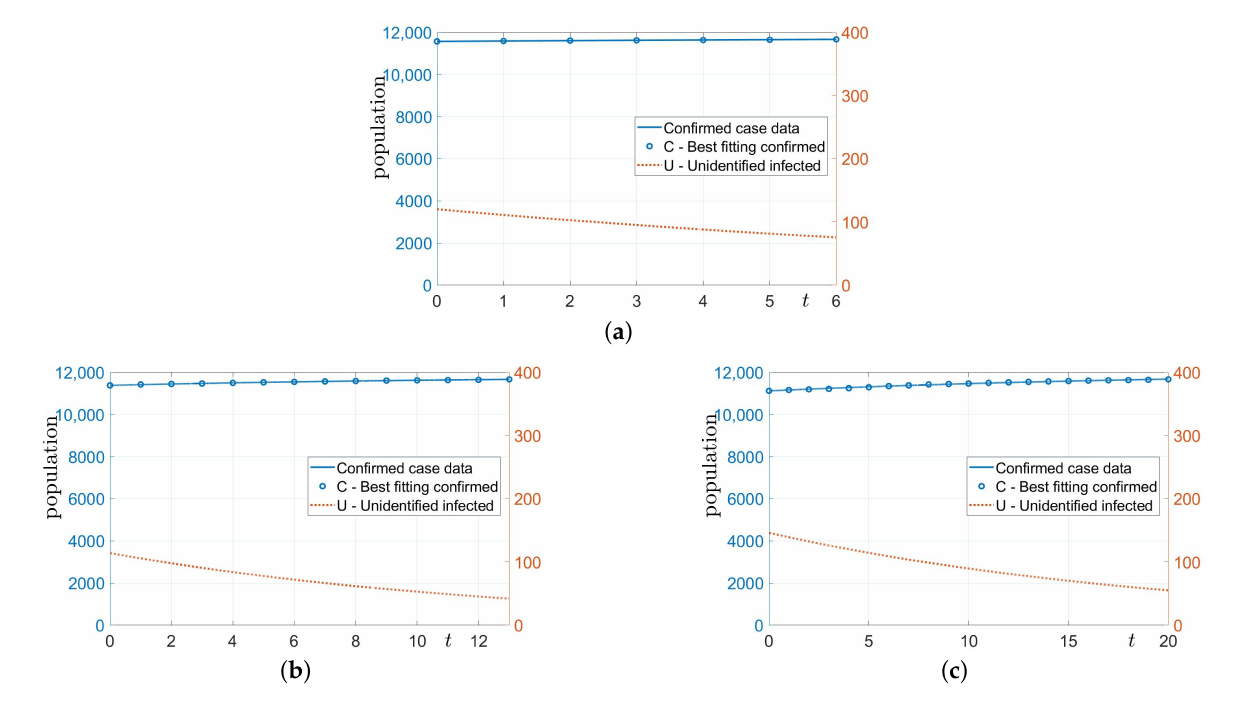
Figure 2. Computational results with ( a ) p = 7, ( b ) p = 14, and ( c ) p = 21. Table 1. Computational results for the best fitting confirmed ( C ) and the unidentified infected ( U ) of COVID-19 with respect to p . The confirmed case data were 11,668 on 17 July 2020.